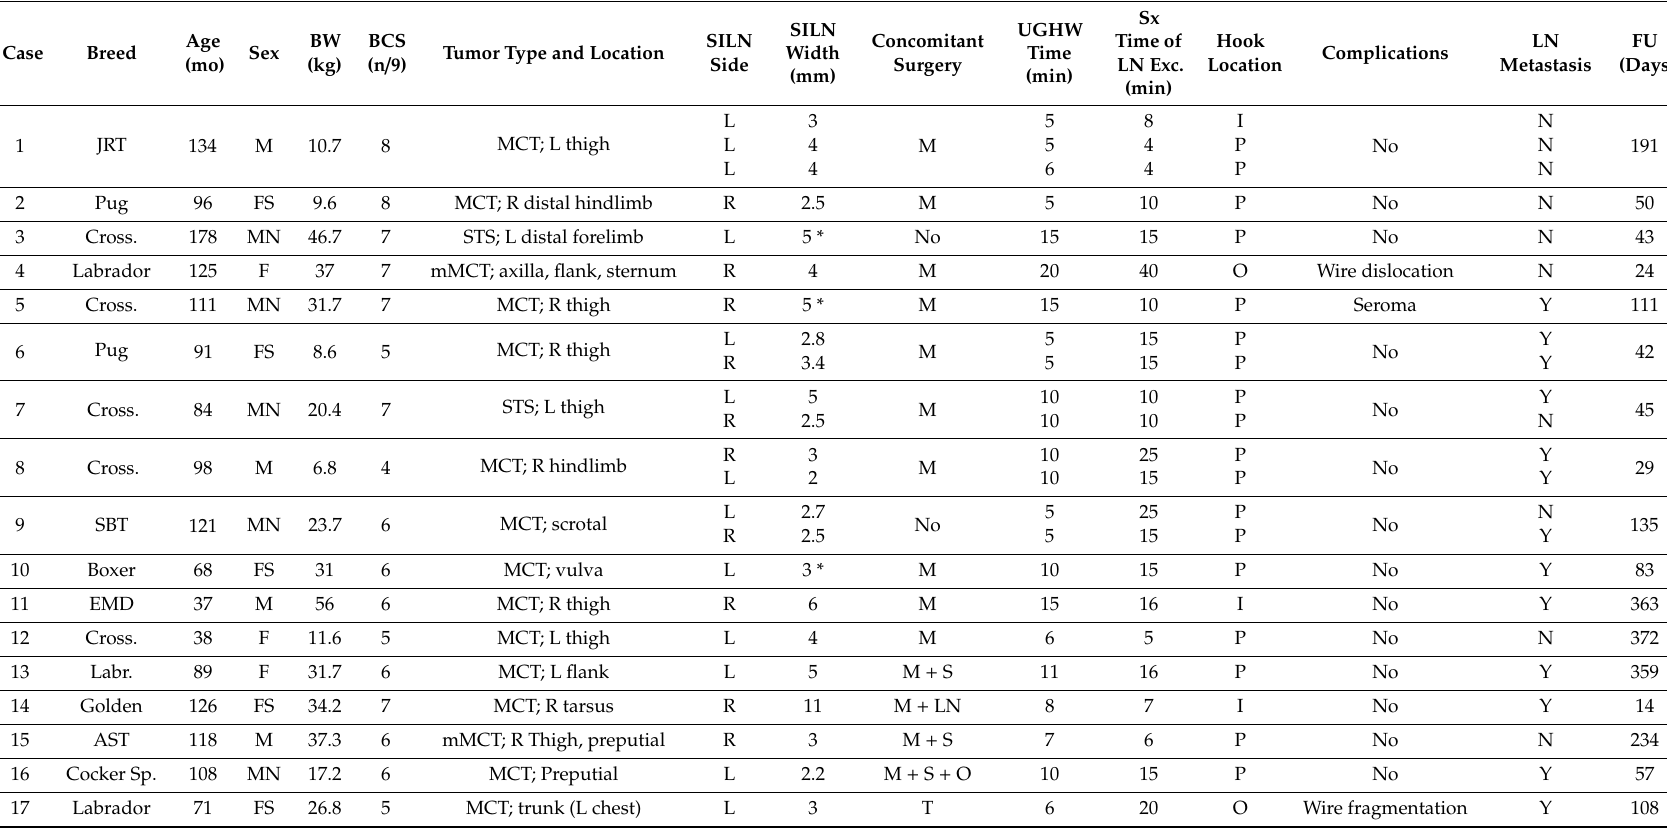
Table 1. Signalment and clinical data regarding ultrasound-guided hook-wire localization and lymph node excision of 17 dogs enrolled in the study.